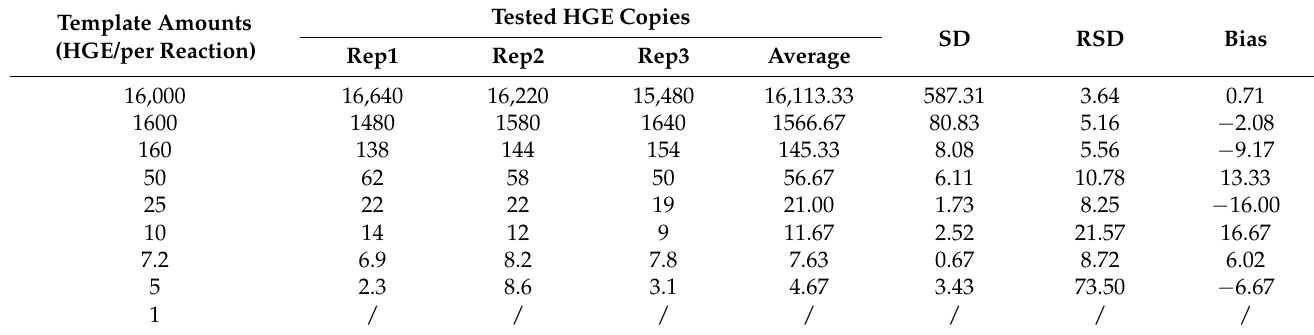
Table 3. Dynamic range and repeatability evaluation of the event-specific ddPCR assay.